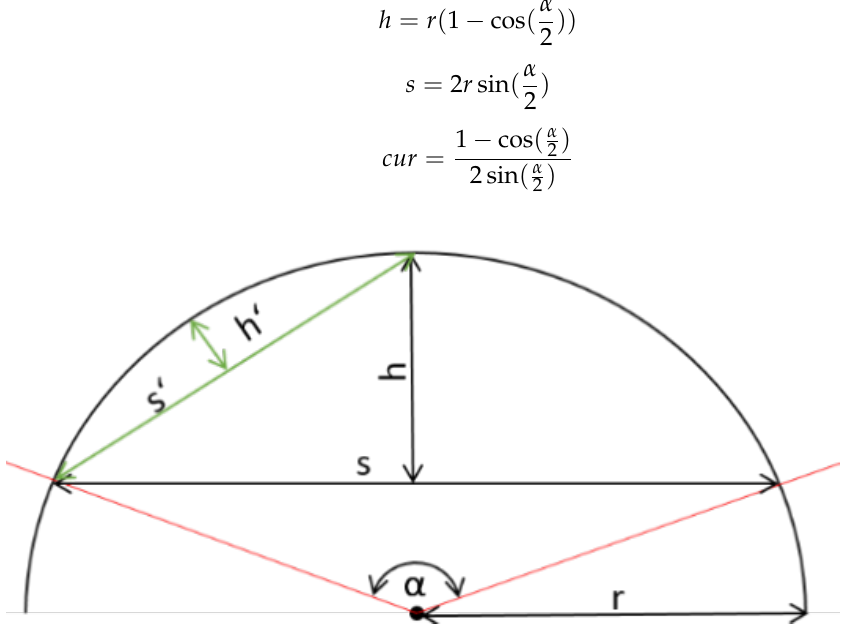
Figure 9. Geometry and elements of a circular arc. The segment height h represents the bow height; the segment length s can be interpreted as the log length.